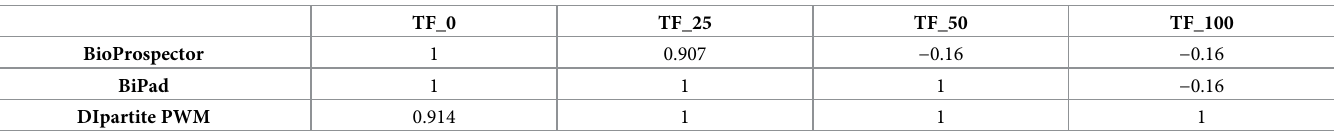
Table 2. The performance of noise detection for the two-block motif. TF_0 TF_25 TF_50 TF_100 BioProspector 1 0.907 − 0.16 − 0.16 BiPad 1 1 1 − 0.16 DIpartite PWM 0.914 1 1 1 The combined nCC values were indicated. Noise sequences were sampled from the genome sequence of human. TF_0 consists of 44 RYAAAKNNNNNNTTGW